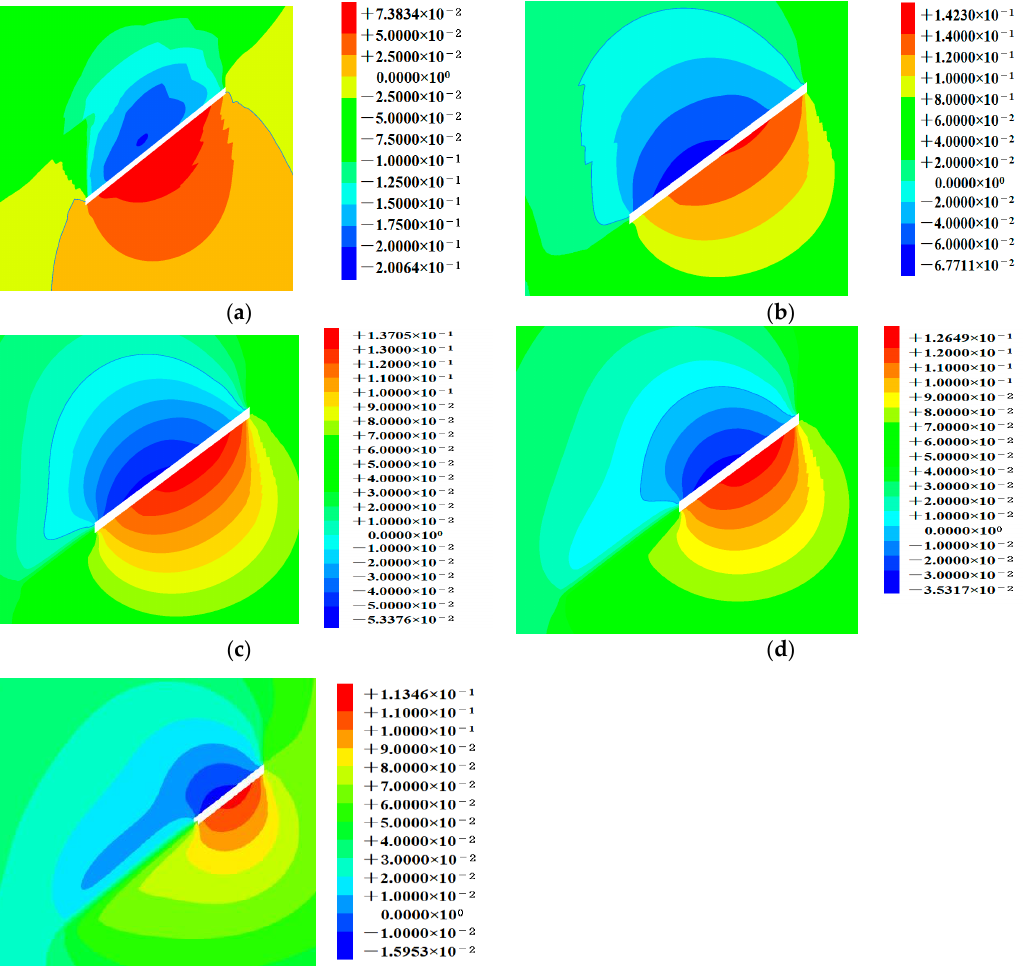
Figure 4. Vertical displacement distribution characteristics of overburden under different filling quantities. Different colors represent different vertical displacement values as shown in the right legend. ( a ) No filling; ( b ) Filling 1/5; ( c ) Filling 1/3; ( d ) Filling 1/2; ( e ) Filling 2/3.